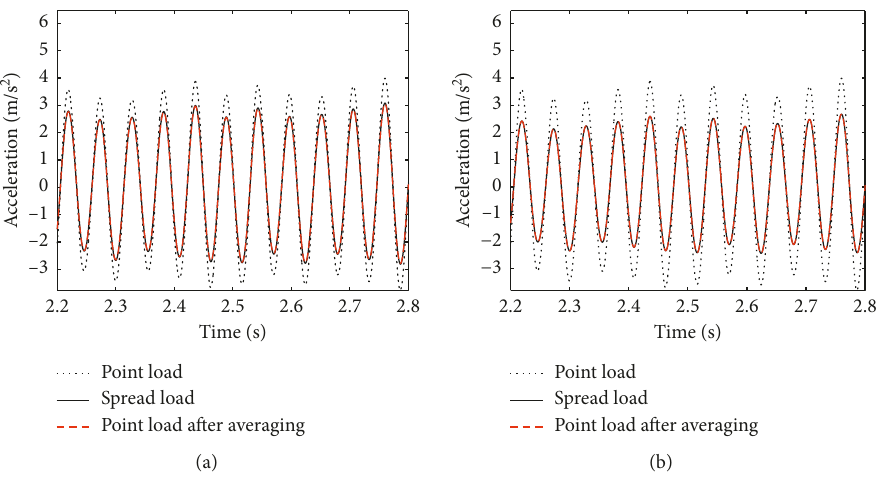
Figure 6: Bridge acceleration time history at resonance speed (ML model). (a) EC block load. (b) Triangular load.